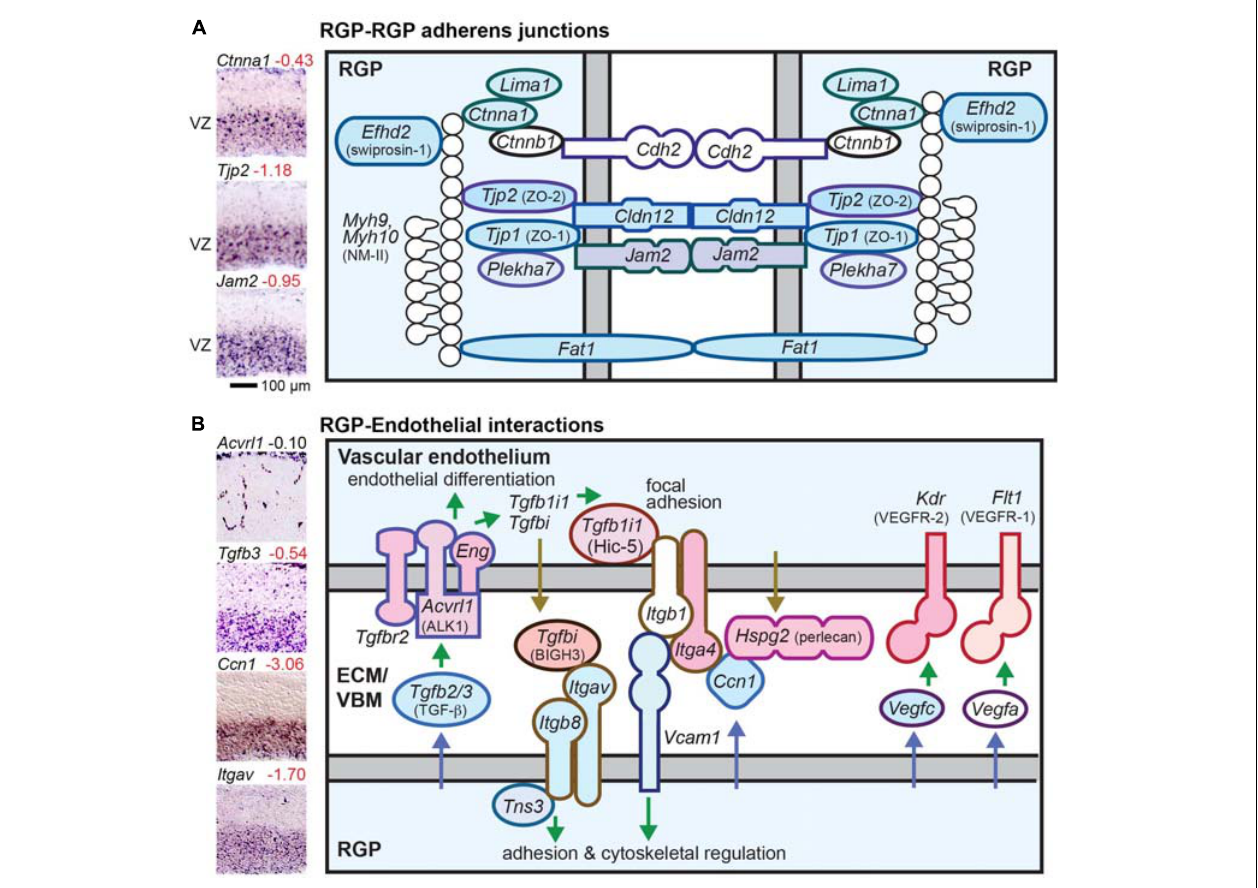
FIGURE 4 | RGP adherens junctions and vascular interactions. (A) The RGP adherens junction includes many tight junction related proteins (TJRPs) encoded by genes such as Tjp1 , Tjp2 , and Jam2 . The junctions form a continuous band around the RGP apical region, called the zonula adherens, which is promoted by Lima1. The adherens junction is linked to the actin cytoskeleton with a contractile ring of F-actin and NMII. Cldn12 promotes paracellular calcium diffusion, and Fat1 is a giant cadherin. (B) RGP interactions with endothelial cells. Key pathways for cortical vascular development include TGF β , Integrin ( α v β 8 ), and VEGF produced by RGPs. Colored shapes indicate cell-type-specific genes; white fill indicates widely expressed